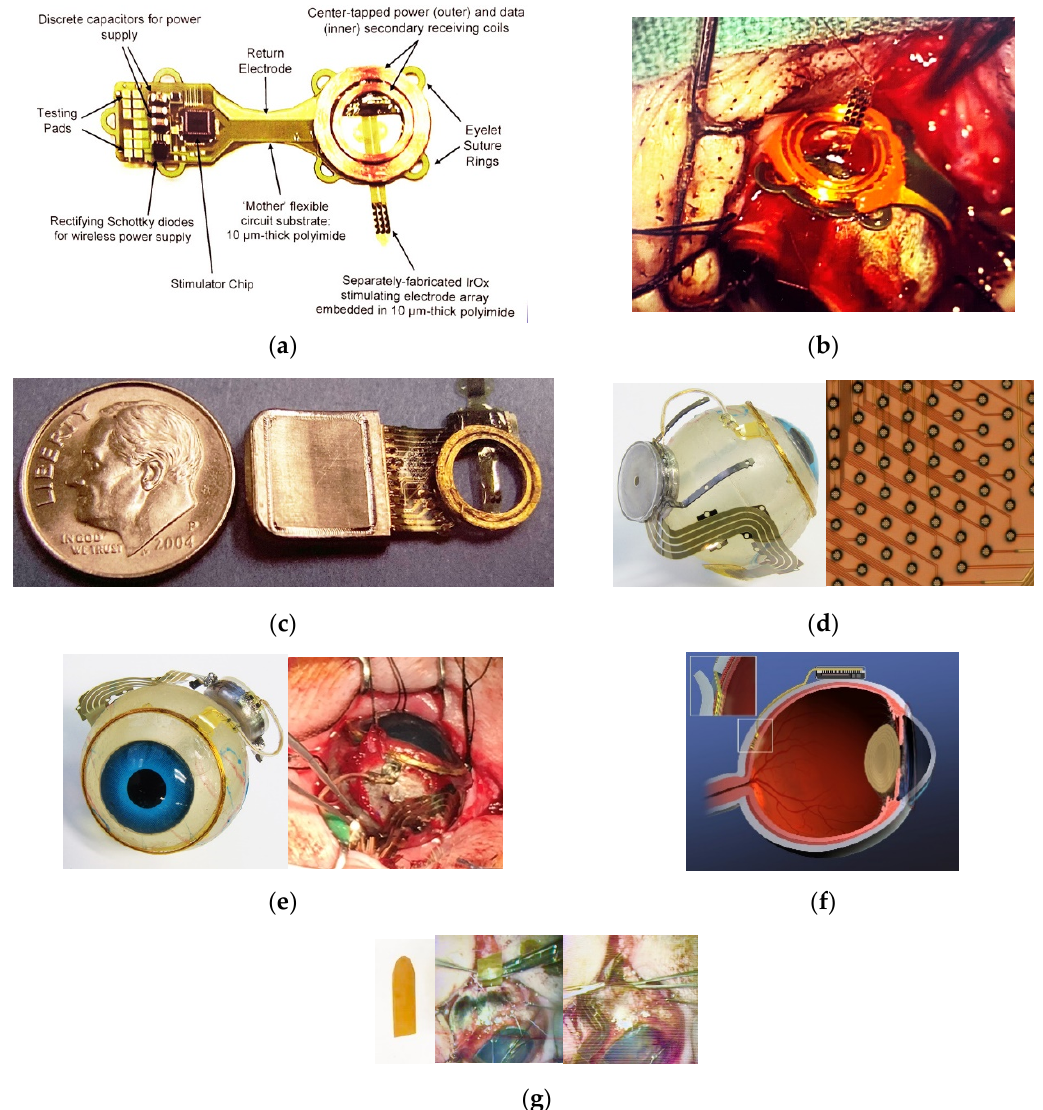
Figure 1. Three generations of the Boston Retinal Prosthesis with micro-fabricated components. ( a , b ) First generation 16-channel stimulator with early micro-fabricated electrode array in mini-pig model; ( c ) second-generation hermetically packaged 16-channel device with bidirectional telemetry; ( d , e ) third-generation hermetically-packaged 256 + channel unit in minipig, and bonded array-feedthrough interconnections prior to final silicone overmolding—the electrode array is 5 mm at widest with segmented leads, and the package is 11 mm in diameter; ( f ) a simplified cross-sectional cartoon of the implant showing the package mounting on the eyeball, the leads along the outside of the eye traversing the eye wall into the subretinal space (inset); ( g ) a 5 mm wide, 15 mm long and 75 µ m thick polyimide surgical guide, and the guide in use during array insertion.